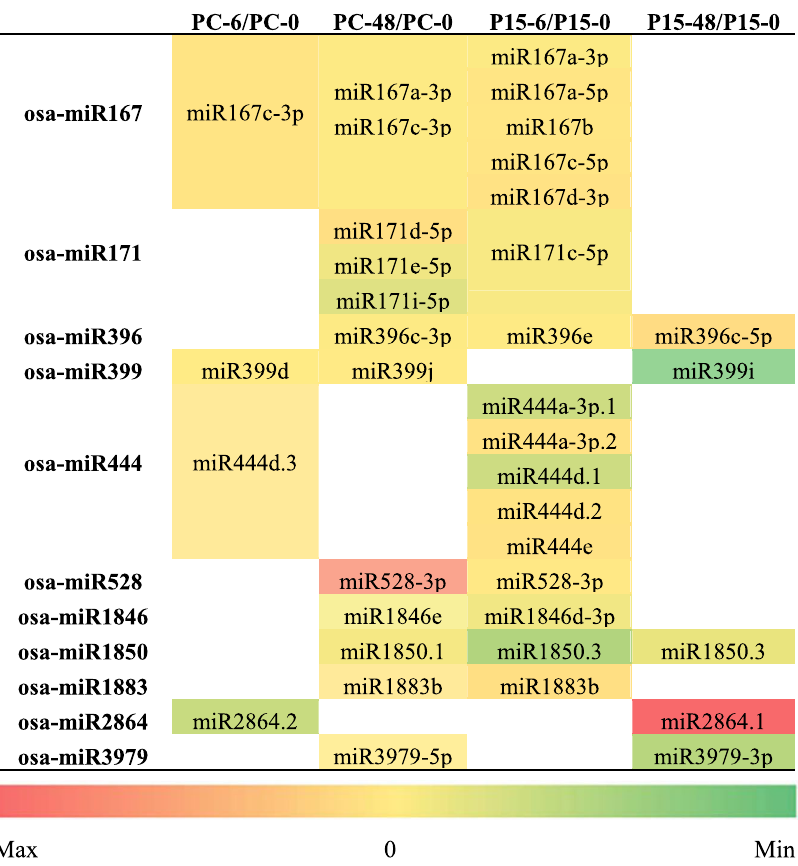
Table 3. Differentially expressed miRNAs within the same families 6 h and 48 h after BPH feeding. The colors represent the fold-change values of the corresponding